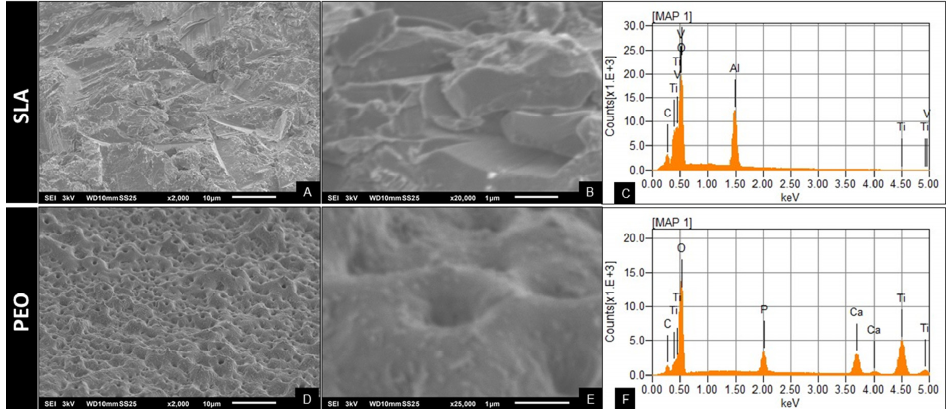
Figure 1. Topographic characterization of surface coating. Scanning electron microscopy (SEM) for sandblasted acid (SLA) on 2.000× ( A ) and 20.000× ( B ) showing irregular surface, dispersive energy spectroscopy for SLA corroborate Ti, Al, and V ( C ); SEM for plasma electrolytic oxidation (PEO) on 2.000× ( D ) and 25.000× ( E ) showing porous surface, such as visually homogeneous pores, with “volcano-like” geometry, and dispersive energy spectroscopy for PEO showing the incorporation of Ca and P ( F ).